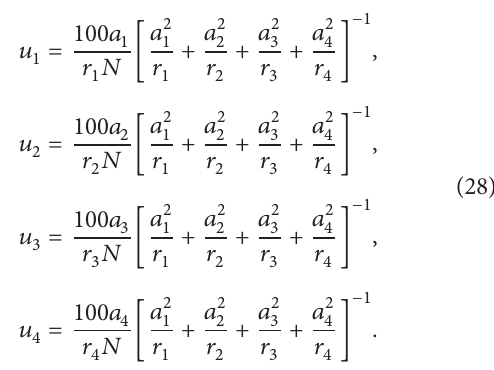
Figure 3: 𝑋 = solution of